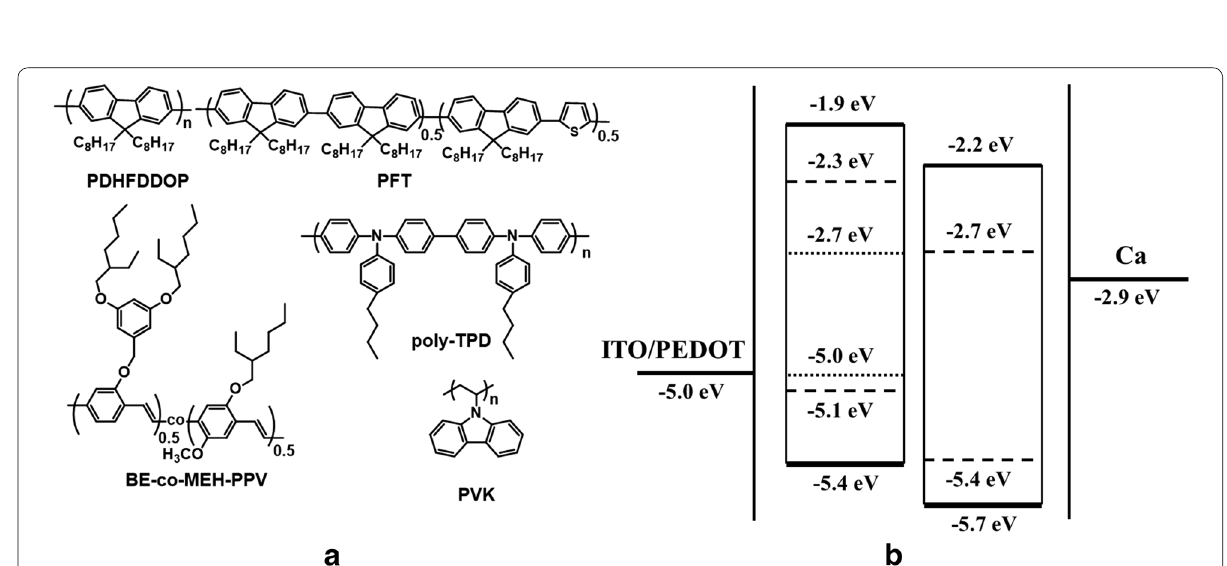
Fig. 8 a Structures of polymers. b Energy level diagram of the WPLEDs [in BEL-PVK: solid line, poly-TPD: dashed line, and BE-co-MEH-PPV: dotted line; in TEL-PFO: solid line and PFT: dashed line] (Reproduced with permission from Ref. [25] Copyright © 2007, American Chemical